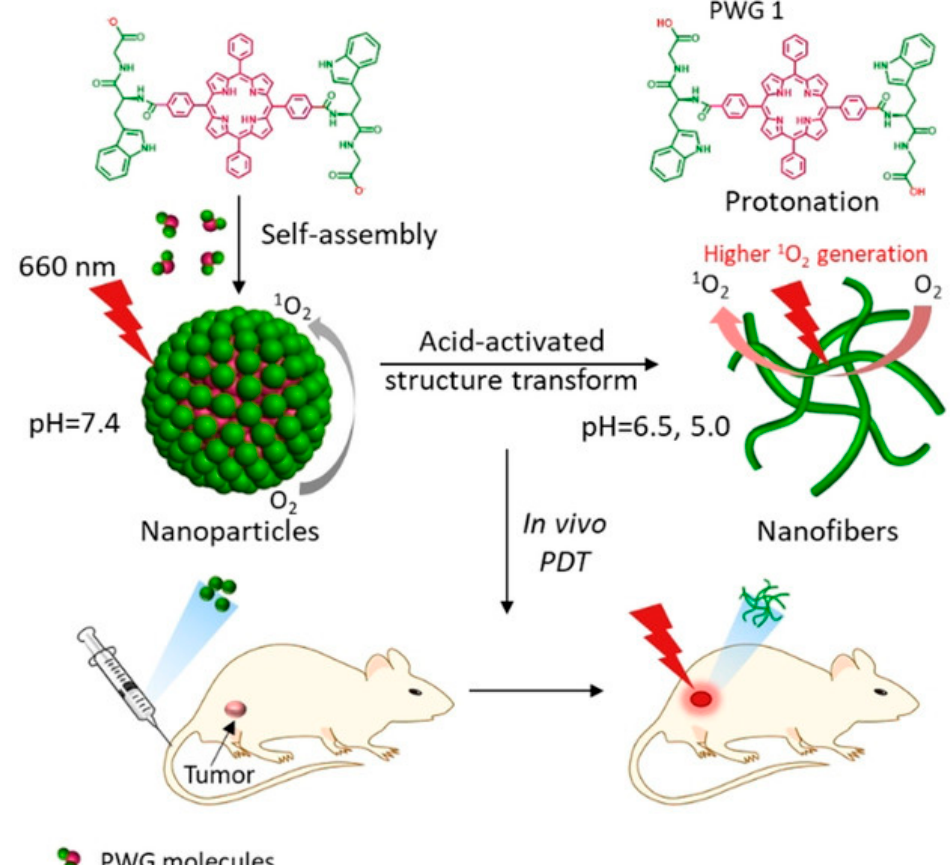
Figure 14. A schematic representation of the self-assembly and fibrillar transformation of the acid- activated peptide-porphyrin (PWG) nanoparticles and their application in PDT. The structure trans- formation in acidic medium enables the accessibility of the laser irradiation to the porphyrin, inducing the singlet oxygen generation in a specific way. Reprinted with permission from Reference [206].